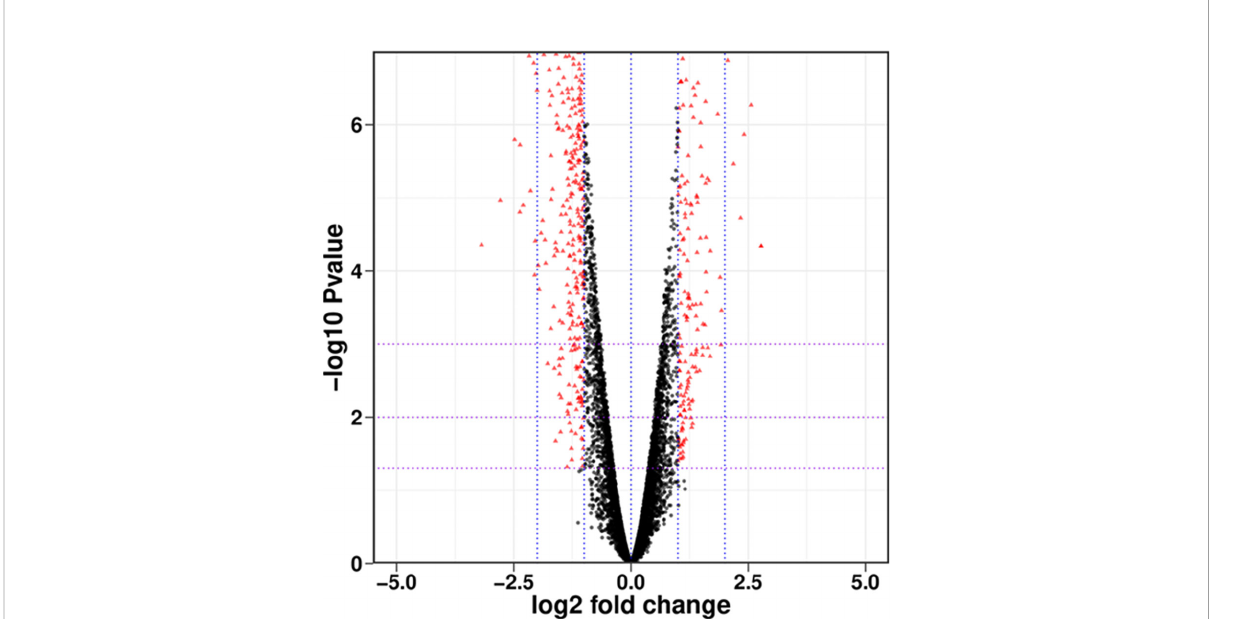
FIGURE 1 Overall distribution of differentially expressed genes (DEGs). Each dot represents a gene, with red indicating signi fi cantly different genes and black indicating genes with no signi fi cant